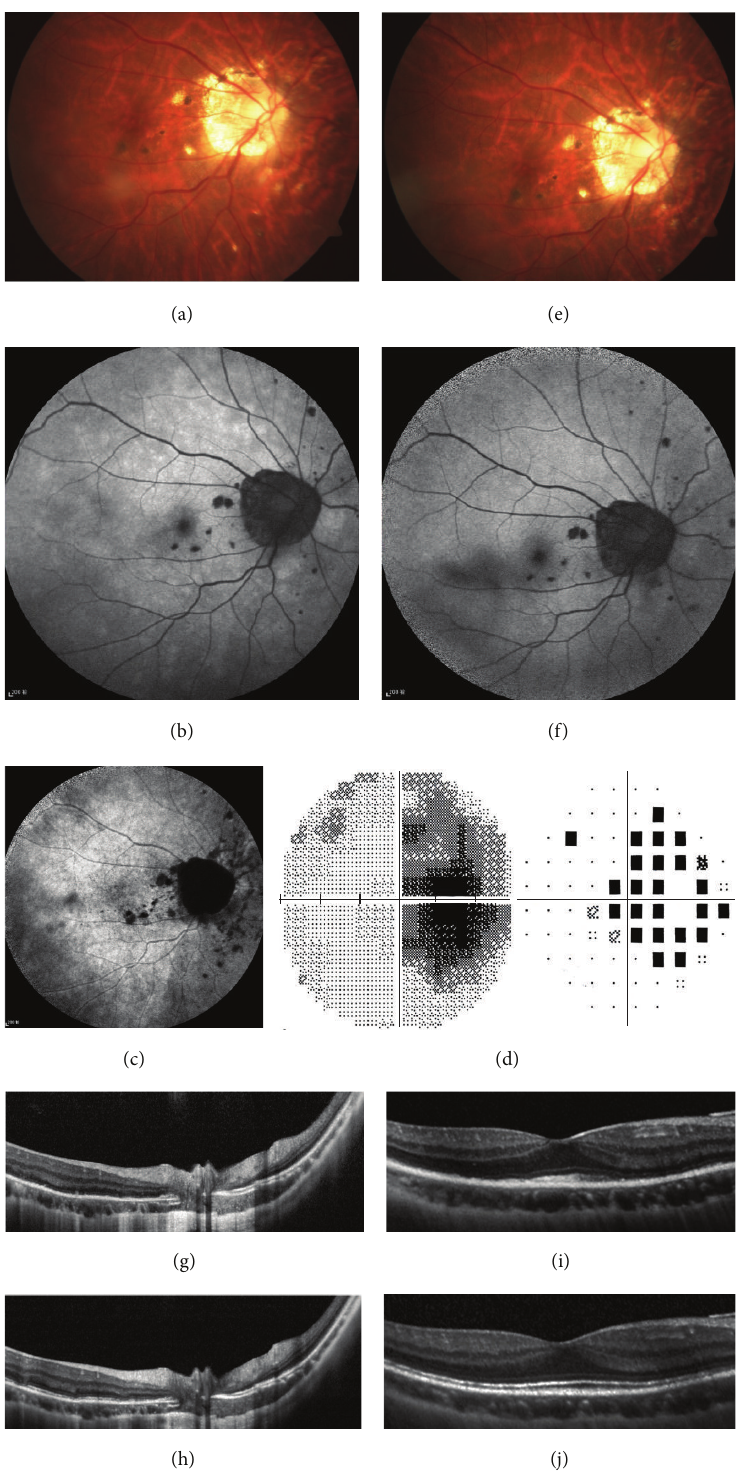
Figure 4: Fundus photography (a, e), SW-FAF (b, f), ICGA (c), perimetry (d), and SD-OCT (g, h, i, and j) of the right eye of a 32-year-old female at the initial visit and 2 months later. The presented BCVA was 0.6. (a) Except for the atrophic lesions of PIC, nothing abnormal was shown on fundus photography. (b) Diffuse hyperautofluorescent patches were detected on SW-FAF, in addition to the hypoautofluorescence of atrophic PIC lesions. (c) Late phase of ICGA was normal in related areas except for some hypocyanescent spots nasal to the optic disc. (d) The visual field examination indicated blind spot enlargement and widespread visual field defects. With relative preservation at the fovea (i), SD-OCT imaging revealed diffuse loss of EZ in the peripapillary zone and in areas that corresponded with the enlarged blind spot. The ONL was preserved (g). Two months later, (e) no obvious change was observed on fundus photography. (f) The intensity of hyperautofluorescence on SW-FAF diminished. (h, j) The EZ reconstructed with focal disruption remained on